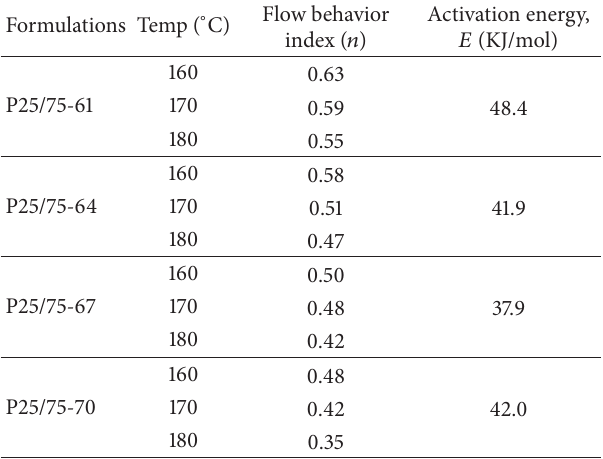
Table 4: Values of 𝑛 and 𝐸 for P25/75